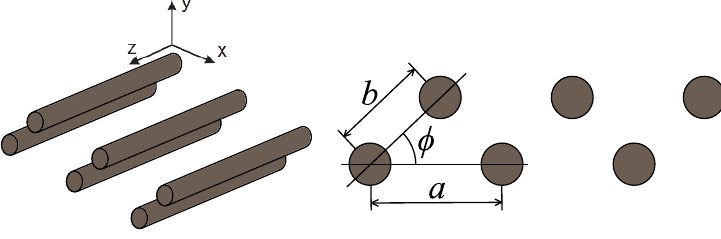
Fig. 2. A waveguide